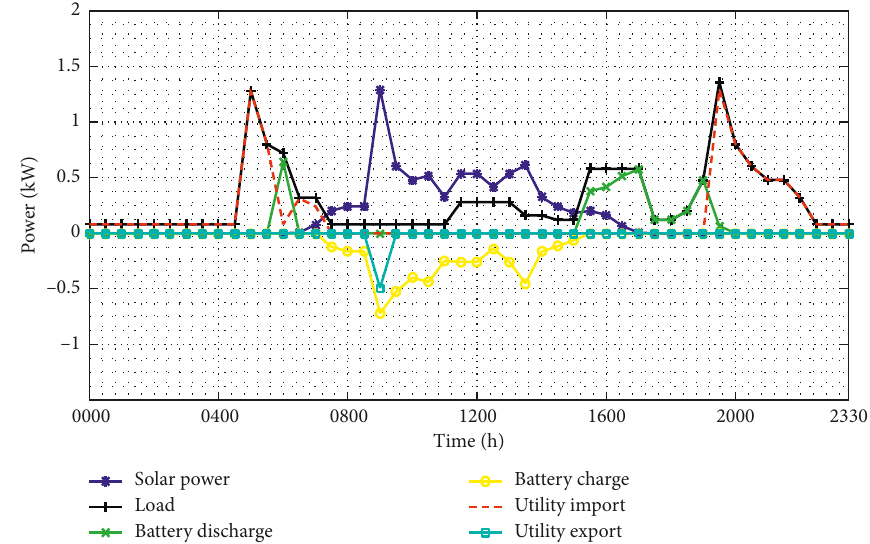
Figure 11: Power source operation of the system without battery local SoC limits for case